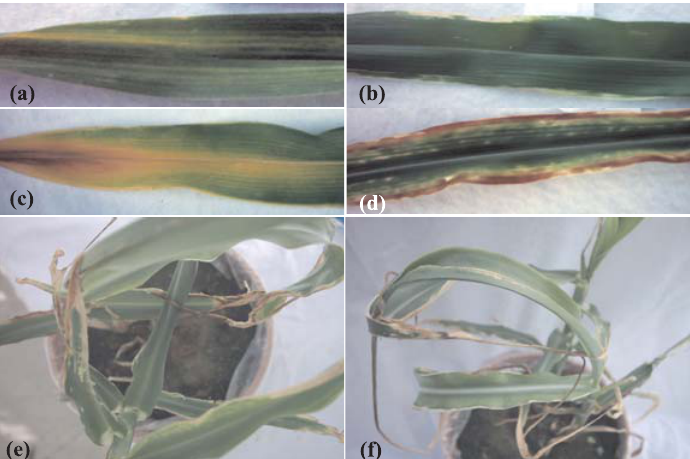
Figura 3. Sintomas visuais da toxidez de Zn e Cd em plantas de milho cultivadas em solo com 50 mg kg -1 de Zn (a) e (b); 100 mg kg -1 de Zn (c) e (d); e com 20 mg kg -1 de Cd (e) e